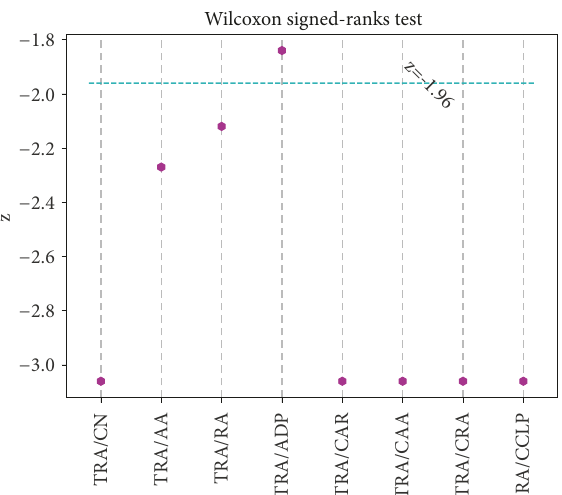
Figure 4: The results of Wilcoxon signed-ranks test based on Table 5. With 𝛼 = 0.05 , if 𝑧 <= −1.96 , the null-hypothesis is rejected.